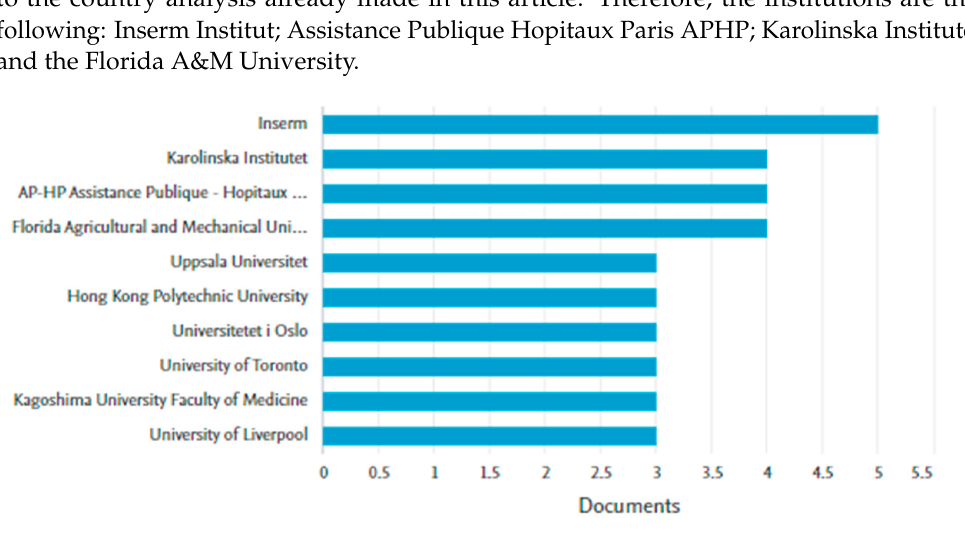
Figure 10. Institutions with the highest number of publications—Scopus.